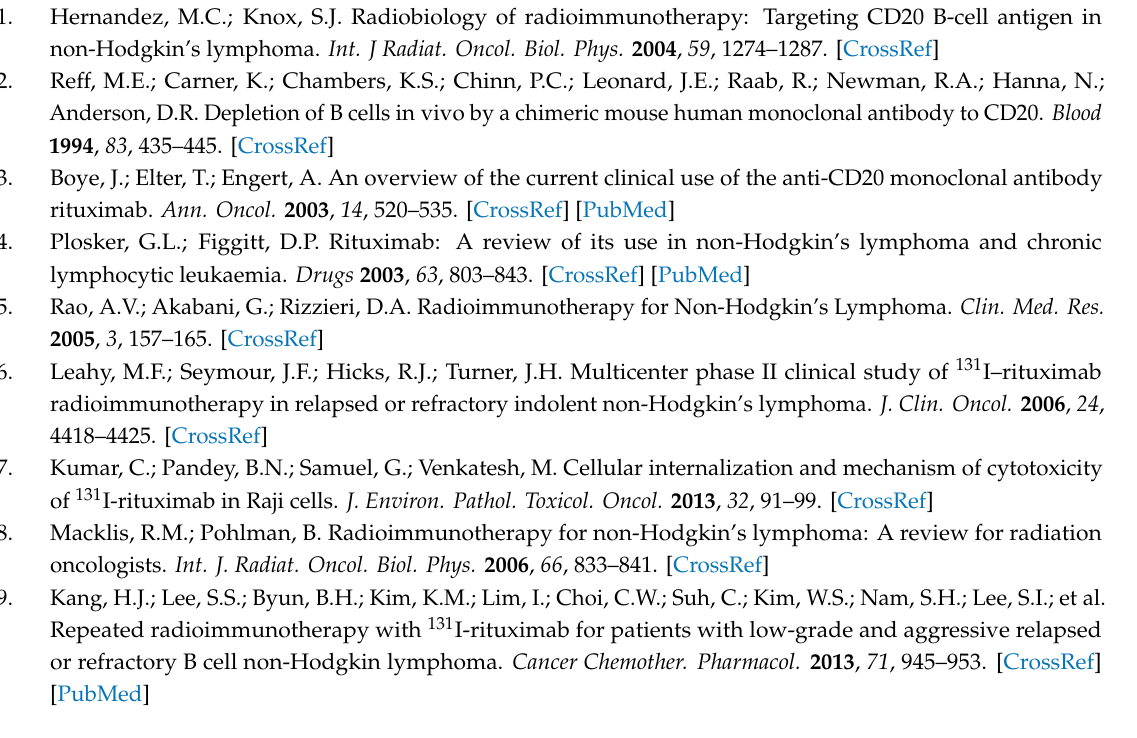
Figure S1: Schematic of study design. RTX (anti CD20 antibody), 131 I-RTX was used as a tool of targeted therapy, Figure S2: (a) After treatment with 10 µ M ATV or 5 µ g / mL RTX in Raji, Jeko-1, Mino, and U2932 lymphoma cells for 2 days, cell viability was determined by alamarBlue assay. (b) After treatment with various concentrations of ATV in Raji cells for 2 days, cell viability was determined by alamarBlue assay. The data were expressed as a percentage of the mean value of untreated control cells and the mean ± SD from three independent experiments. (c) Tumor volume of each mouse, Figure S3: (a) ATV inhibited the viability of Raji cells, but hypoxia-induced Raji cells were less sensitive to ATV than the control. (b) The dysfunction in tube formation was significantly decreased after ATV treatment, Figure S4: (a) Cell viability was determined after treatment with ATV and miR-346 transfection. The proliferation rate was measured by trypan blue exclusion method of cell viability. (b). The cells were co-transfected with either miR-346 or control mimics and 200 ng pGL3 reporter construct containing wild-type. The relative firefly luciferase activities normalized with Renilla luciferase were measured 48 h post-transfection, and the results are plotted as percentage change over respective controls (c). Tumor cell invasion and angiogenesis were assessed using Matrigel invasion assay and tube formation assay. Representative photomicrographs of in vitro tube formation. We co-transfected miR-346 mimic or mimic control with or without ATV treatment into Raji cells. (d) Transcriptional activity of HIF-1 α (** p < 0.005, * p < 0.05). (e). Transcriptional activity of VEGF (** p < 0.005, * p < 0.05). (f) Cell viability: the decreased cell viability induced by miR-346 was restored by HIF-1 α ∆ 3 (cid:48) UTR overexpression (** p < 0.005, * p < 0.05), Figure S5: (a) The relative expression of miR-346 in Raji cells was analyzed according to the concentration of miR-346 inhibitor by qRT-PCR (** p < 0.005). (b) Representative photomicrographs of in vitro tube formation after each treatment. (c) No weight change in the spleen and lung was detected, clearly indicating absence of acute toxicity, Figure S6: (a) Relative cell tumor invasion (%) by Matrigel invasion assay. (b) Cell viability: control and hypoxia-induced Raji cells received irradiation (6 Gy), atorvastatin treatment, or irradiation (6 Gy) + ATV for 48 h. (c, d) Upregulated expression of miR-1182 and miR-608, which are related to inhibition of tumor growth and induction of cell